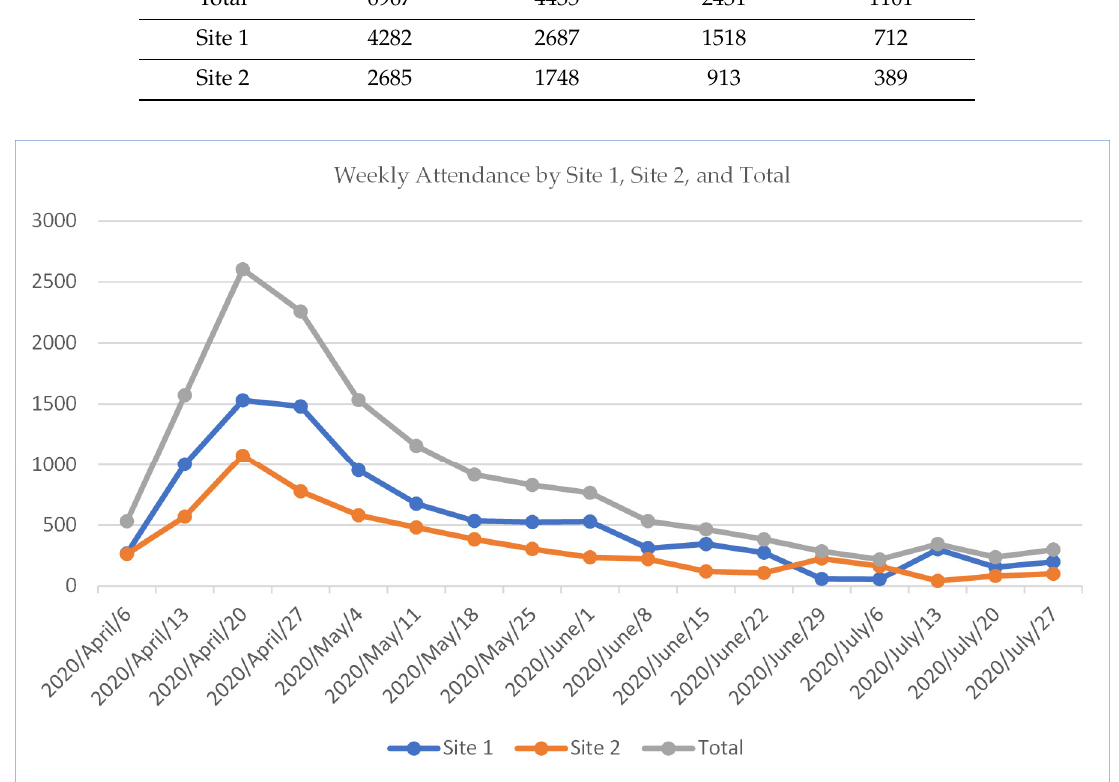
Figure 1. Weekly attendance at wellbeing centres.